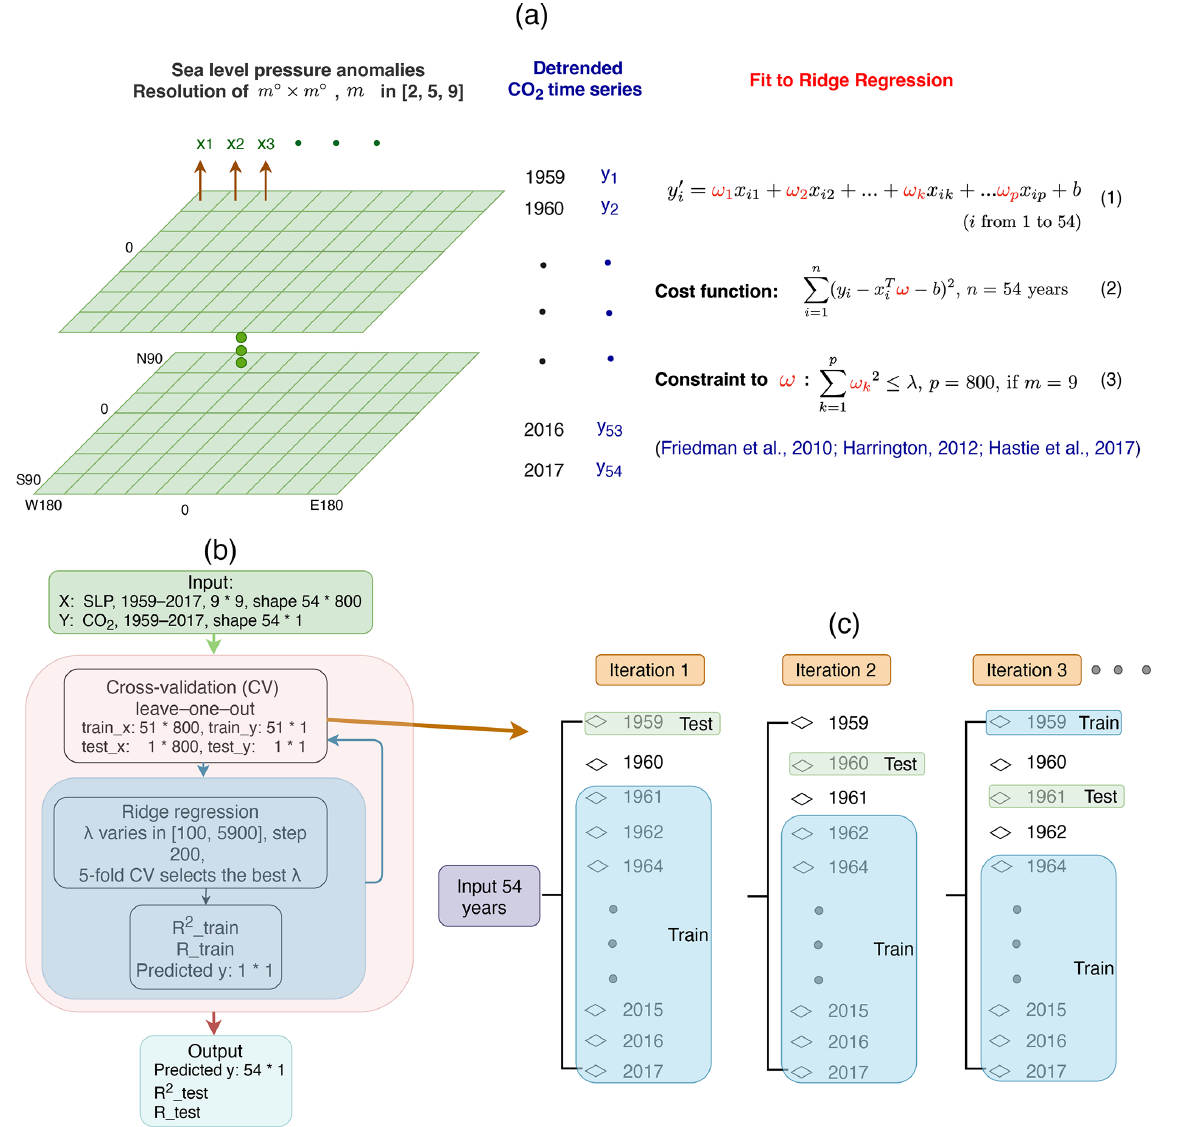
Figure 1. Schematic representation of the statistical approach and model design, with an example of the selected time interval of 1959– 2017. (a) Fundamental principle of ridge regression. (b) Model training and validation under ridge regression leave-one-out cross-validation. (c) Training and testing grouping through leave-one-out